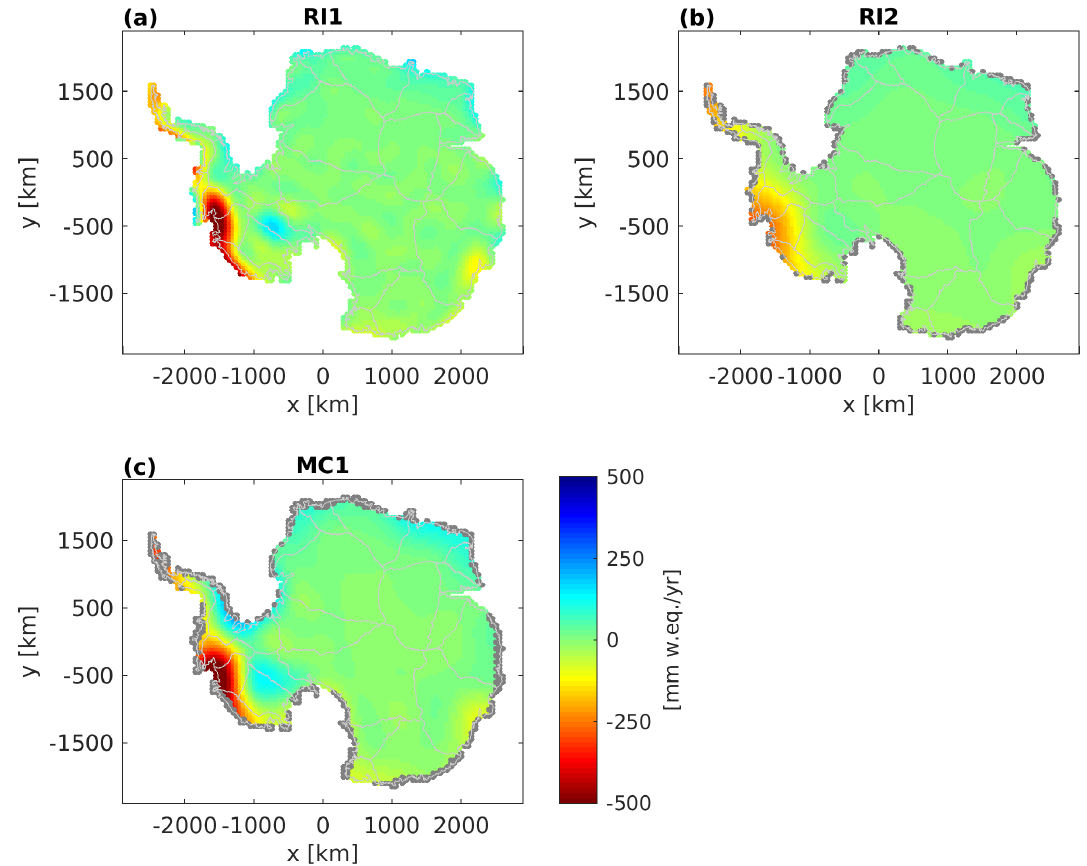
Figure 7. Linear trends derived from the gridded mass changes, using a consistent linear, periodic (1 yr, 1/2 yr, 161/365.25 yr) and quadratic model, and interpolated to the prescribed regular polar-stereographic grid. Panels ( a – c ) show results from different groups (Table 3). Grid cells in grey lie outside of the original grid